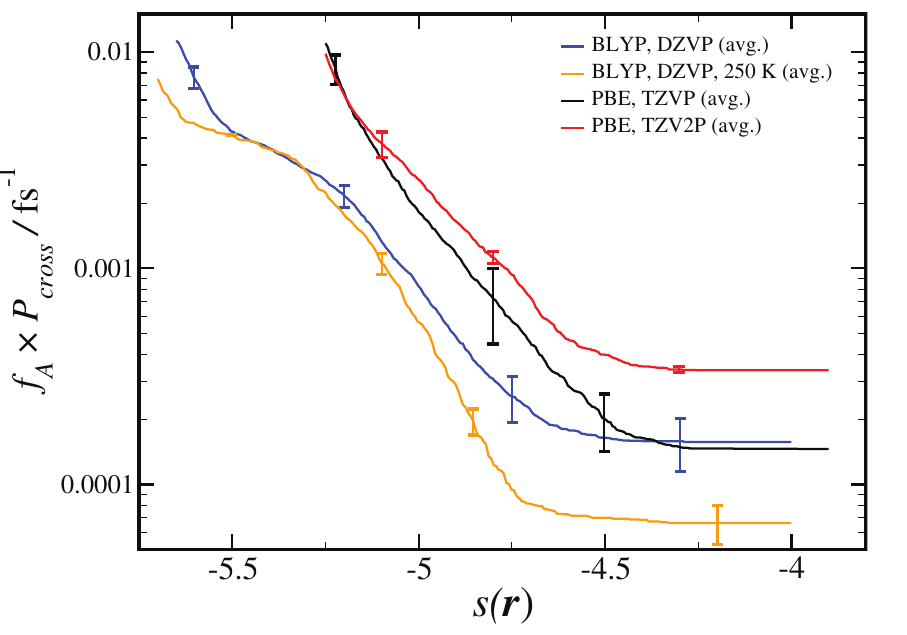
Figure 2 Results from RETIS calculation of the uni-molecular reaction rate ( f A × P cross ), as a function of the order parameter s ( r ) de fi ned in Eq. (1). Results for a given DFT method, basis set and tem- perature are averaged over the different initial con fi gurations and sets of interfaces shown in Table 2, with the standard error in the mean displayed for representative points. All results are calculated at T = 300 K unless otherwise